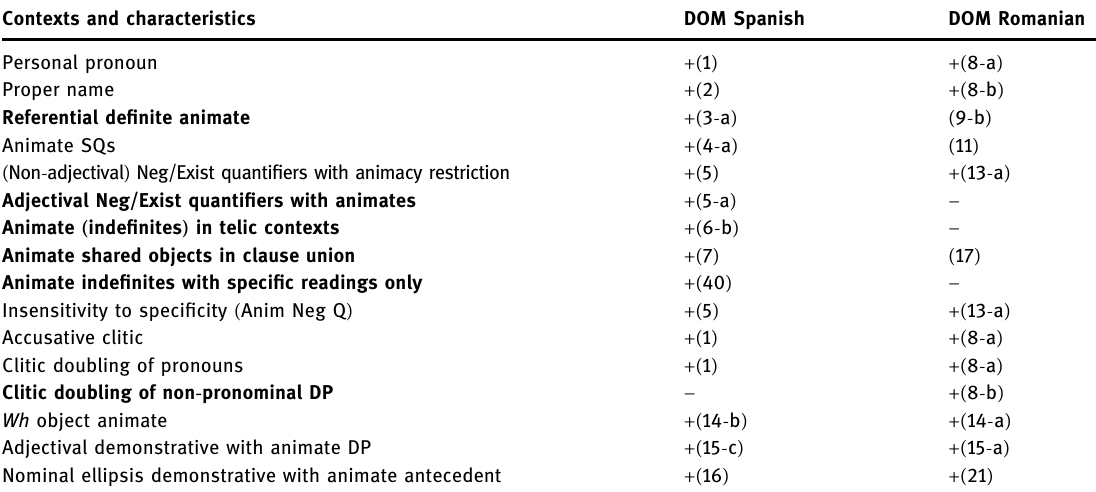
Contexts and characteristics Personal pronoun +( 1 ) Proper name Animate SQs